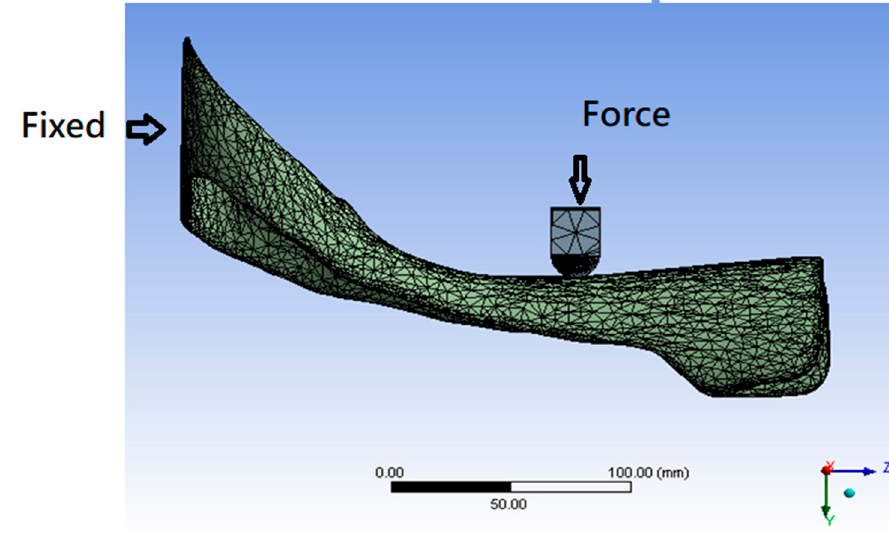
Figure 3. Finite element model of AAFO with the indenter.